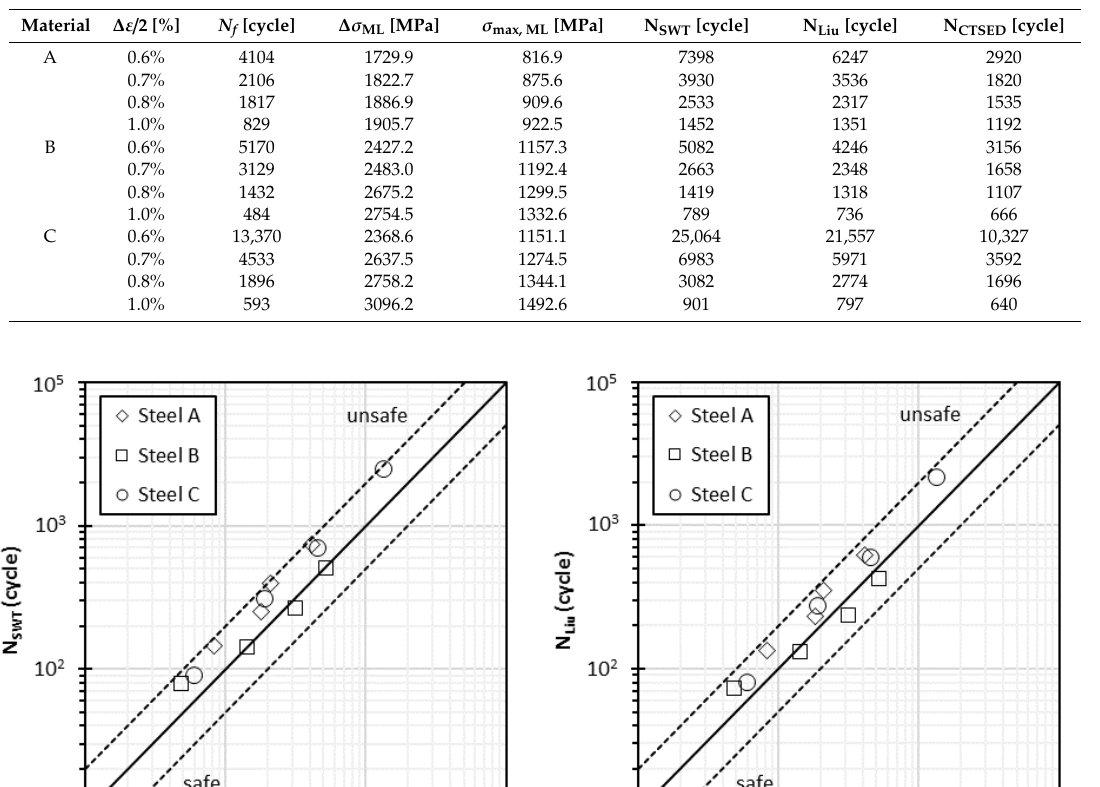
Table 5. Fatigue life predictions and experimental fatigue lives.